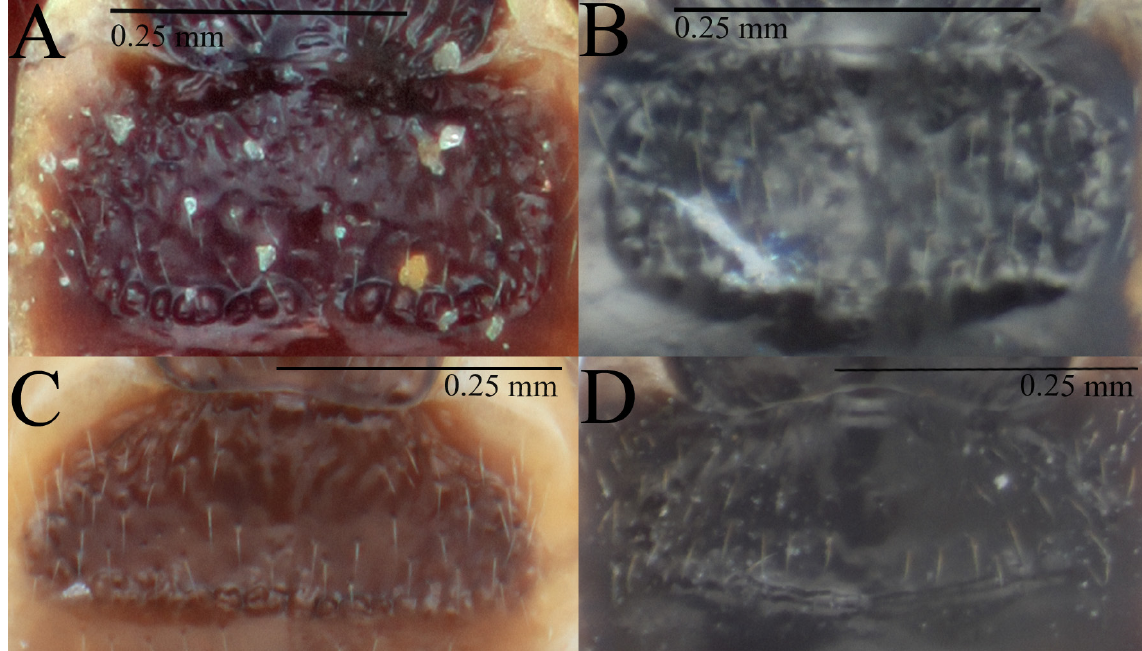
Fig. 10. A . Cotesia anthelae (Wilkinson, 1928), T2 (paratype, NHMUK 3.c.002). B . C. wonboynensis sp. nov., T2 (holotype ANIC 32 130294). C . C. medusae sp. nov., T2 (paratype, QM T246705). D . C. scripta sp. nov., T2 (paratype, MV